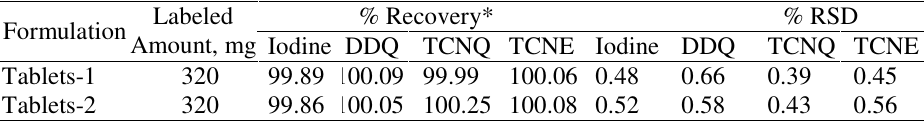
Table 3. Determination of GFX in pharmaceutical formulations by the proposed methods